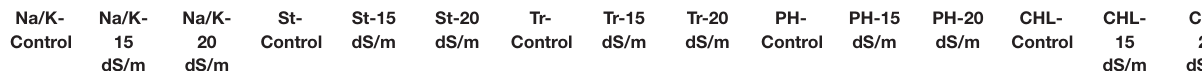
TABLE 9 | Correlation matrix for physiological traits under control and salt stress conditions. Variables